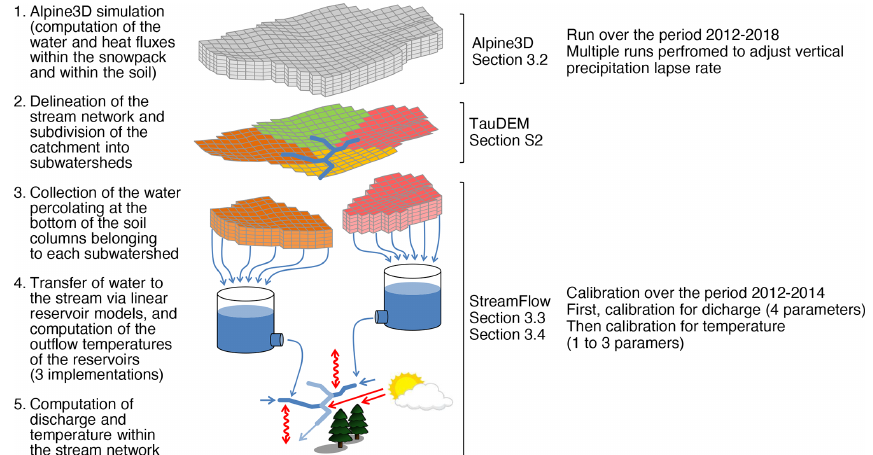
Figure 2. Details of the models’ workflow. The calibration and validation periods indicated are valid for all catchments except for the Eulach catchment (where the periods 2015–2016 and 2017–2018 are used instead). Figure adapted from Gallice et al.